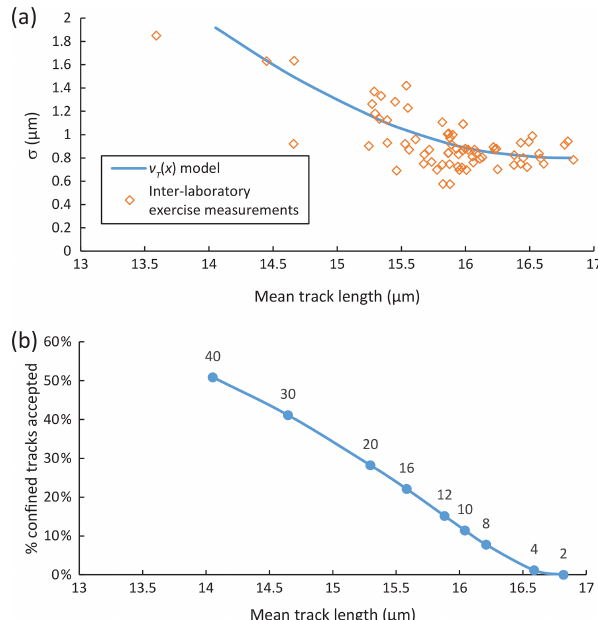
Figure 18. Model relationship between analyst selection criteria (approximated as v T /v B at the track tips) and dispersion and effi- ciency for unannealed induced tracks in Durango apatite. (a) Points show the relationship between mean track lengths and standard de- viation. The line shows the prediction of a v T ( x ) model assuming only variation in v T /v B and a baseline 0.8µm standard deviation of latent track length. (b) Curve of efficiency (percent of all confined tracks intersected that are accepted) versus mean track length as it varies with v T /v B (values above